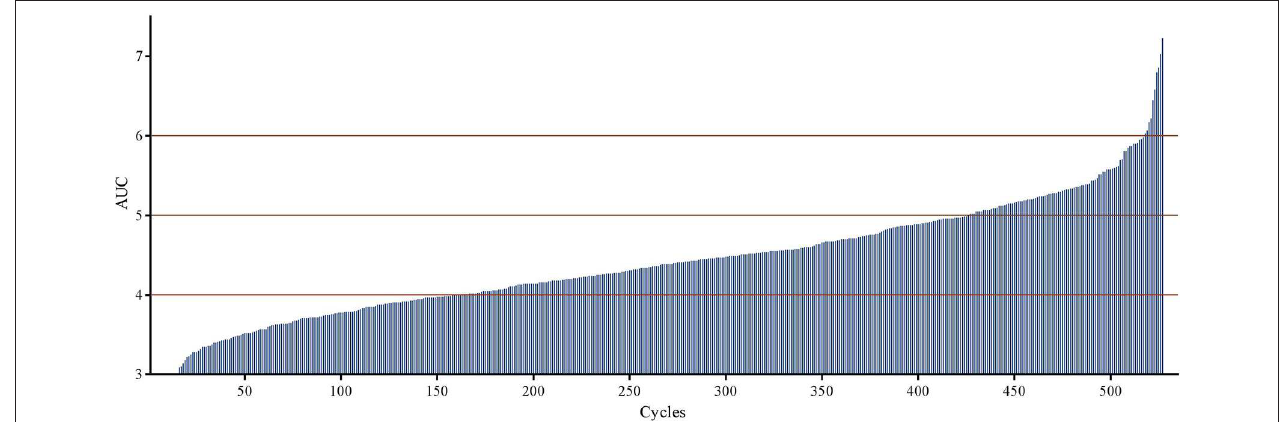
FIGURE 4 | Distribution of carboplatin AUC. Each vertical bar on the horizontal axis represents a chemotherapy cycle.